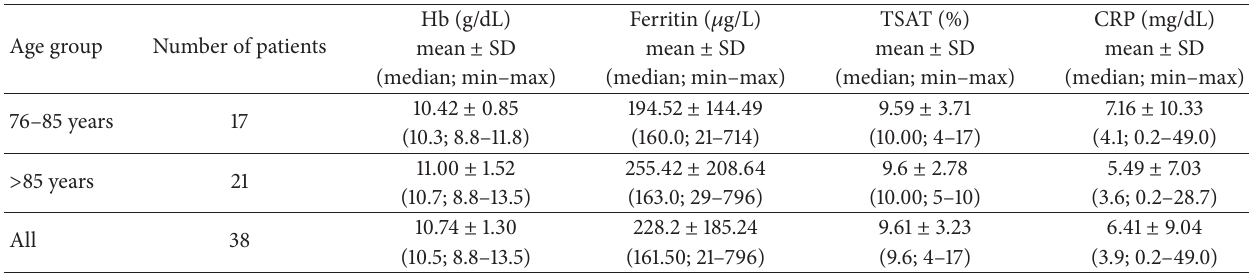
Table 2: Baseline iron parameters of all patients aged > 75 years, subdivided into age groups. Age